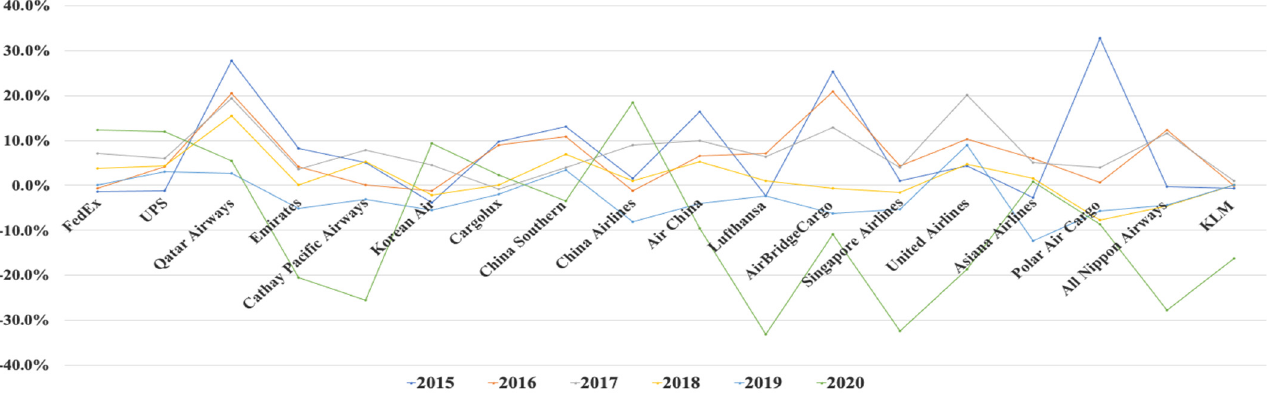
Figure 9. Evolution of total percentage freight tons carried by 16 cargo airlines (2015–2020). Source: